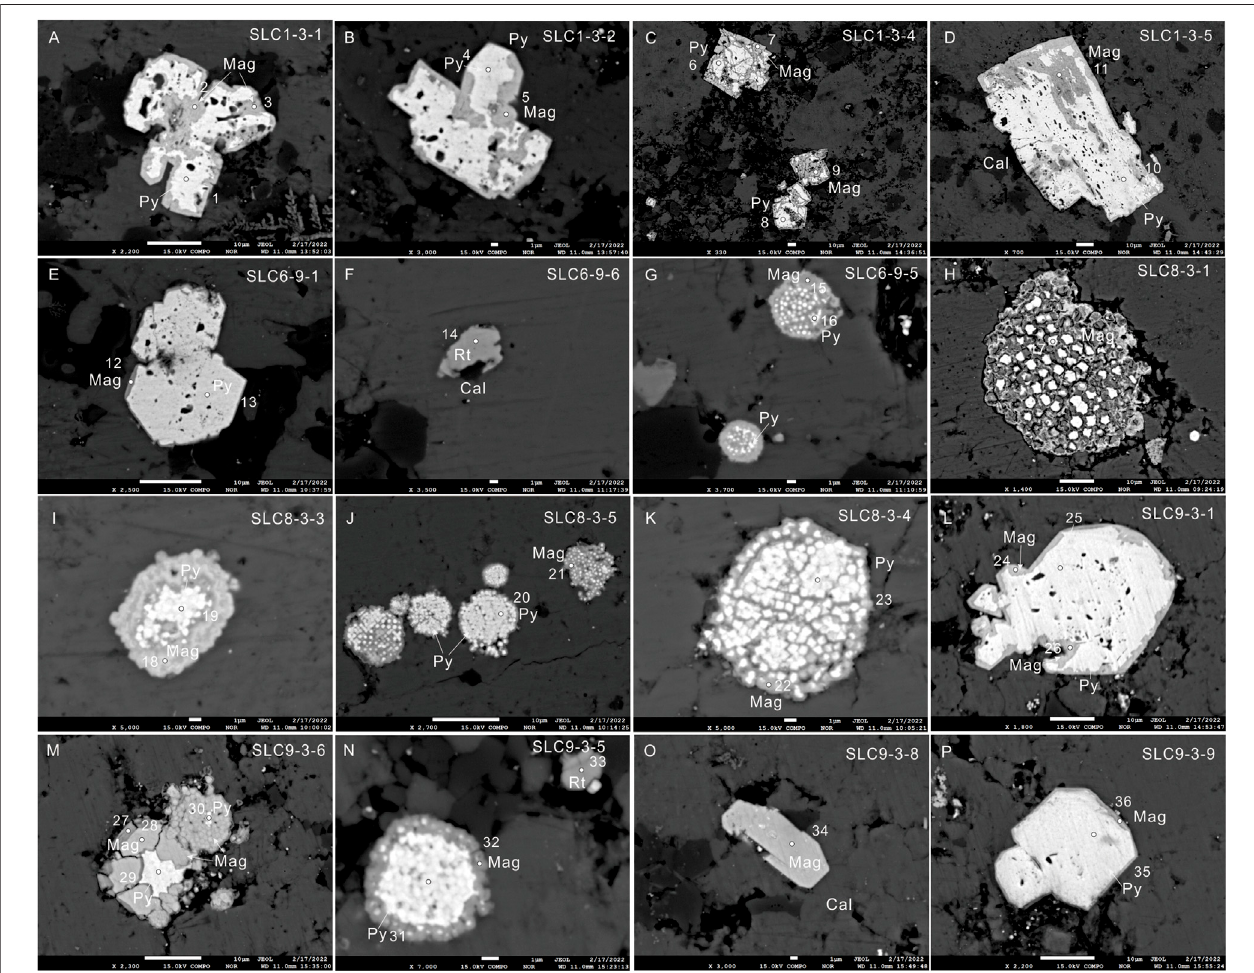
FIGURE3| Backscatterelectronimagesofrepresentativesamples.Whitedotsandnumbersaretheenergydispersivespectrometryanalysisspotswiththeresults shown in Figure 4 . Abbreviations: Mag: magnetite, Py: pyrite, Cal: calcite, and Rt: rutile.